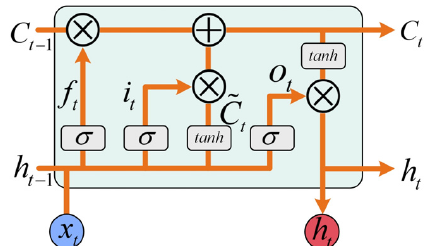
Figure 7. LSTM cell architecture. Figure 7. LSTM cell